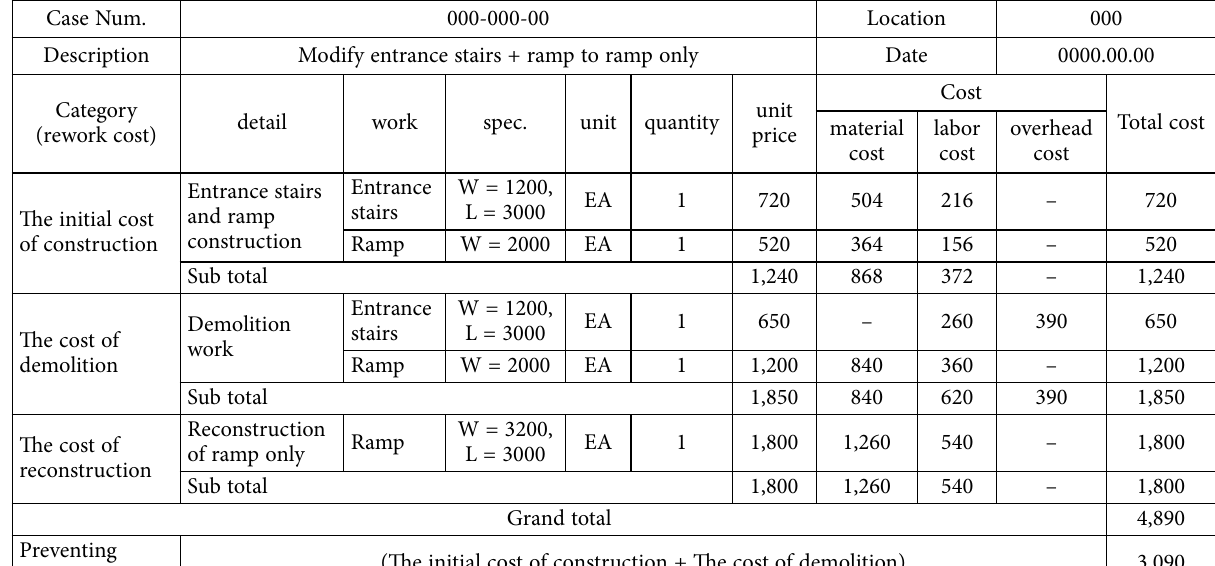
Table 2. Example of a rework cost estimation